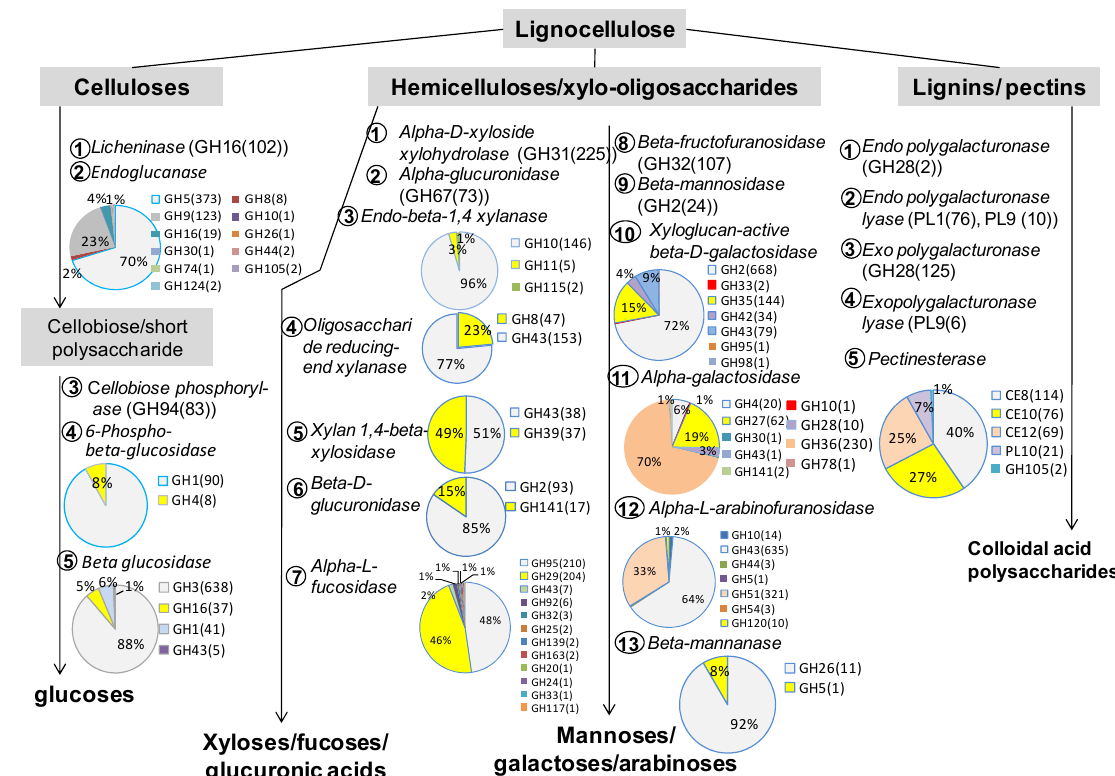
Figure 2. Overview picture of GHs related to lignocellulose degradation of bacteria in Co and Bach Thao goats’ rumen. Lignocellulose in the goats’ diet composed of three mains components: celluloses, hemicelluloses, and lignins/pectins. In the goats’ rumen, celluloses were digested by mainly 5 enzymes to release glucoses. Hemicelluloses were degraded by at least 13 enzymes to generate xyloses, fucoses, glucuronic acids, mannoses, galactoses, and arabinoses. Lignins/pectins were hydrolyzed by 5 dominant enzymes to produce colloidal acid polysaccharides. Some enzymes classified into only one family of GH for example licheninase. In the document, we found 102 genes coding lichenninase GH16, so abbreviated licheninase to (GH16(102)). Some enzymes had very diverse GH, for example, endo glucanase. Abbreviation: GH family (number of genes).